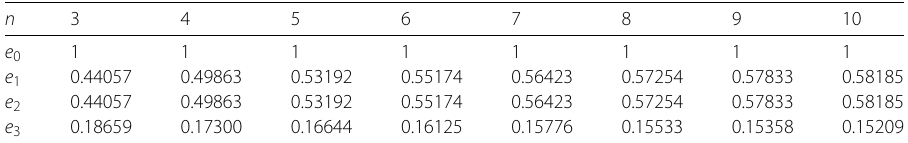
Table 4 Eigen-values of of hyperbolic (i.e., μ (cid:2) +1 = cosh( π /3 × 2 (cid:2) +1 )) subdivision matrix with valence n n